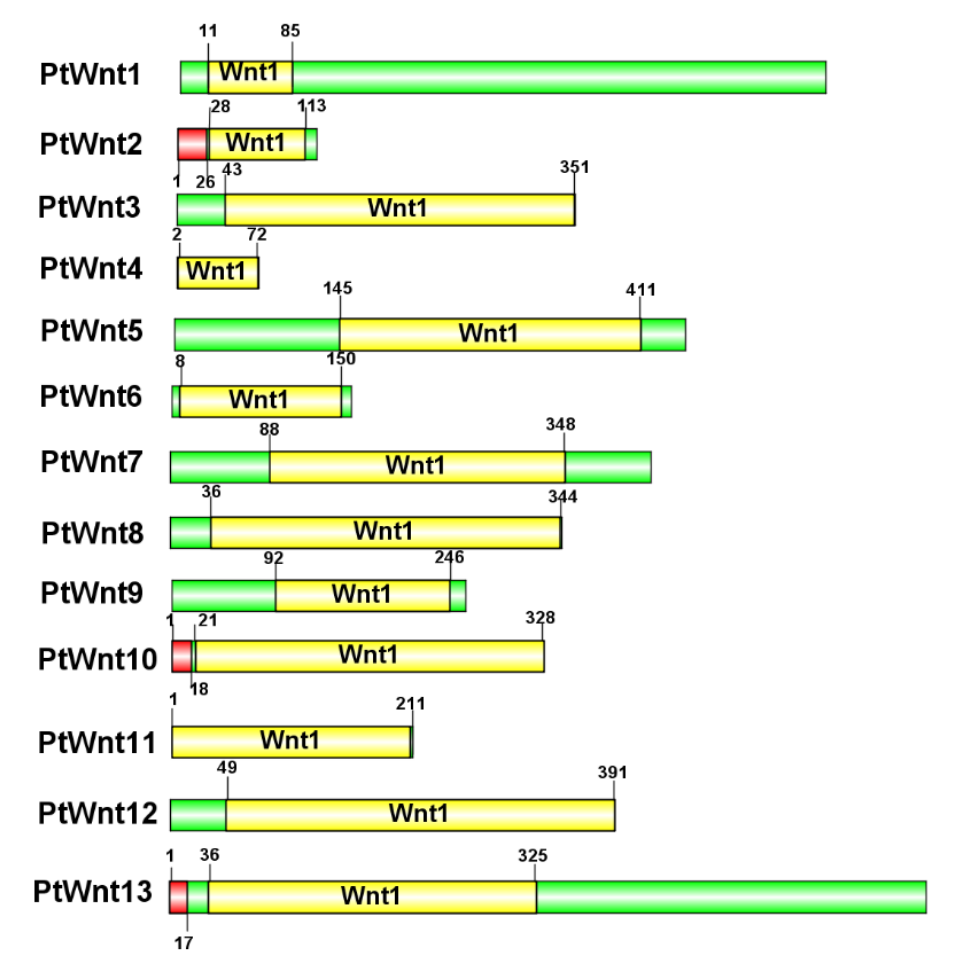
Figure 4. Structure of PtWnt proteins. The yellow boxes indicate the conserved Wnt1 domains. The red boxes show signal peptides. The green boxes indicate non-specific domains.